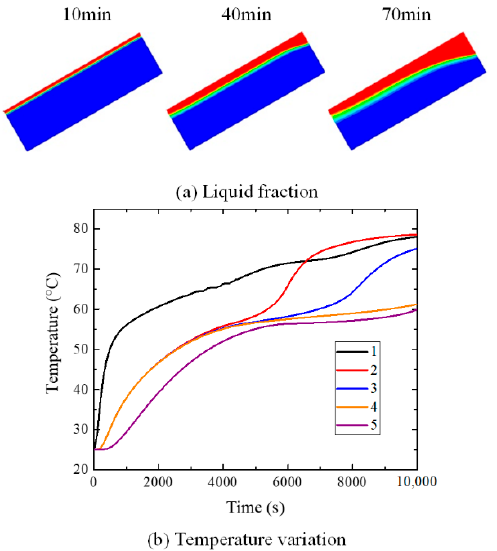
Figure 14. The melting process of paraffin at 150°. ( a ) Liquid fraction; ( b ) temperature variation.